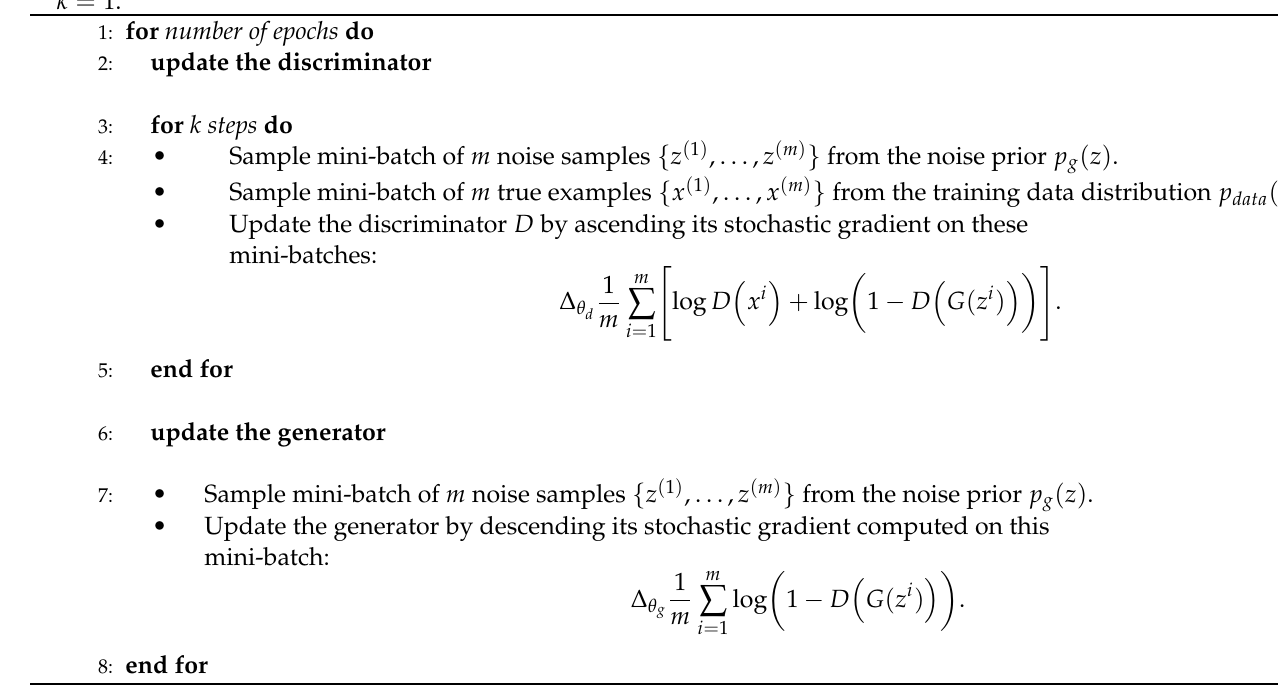
Algorithm 1: Mini-batch SG ascent of GANs with the original objective for MM-GAN. The number of steps to apply to D , k , is a hyper-parameter. For every training of G , we train D k times. Goodfellow et al. (2014) used k =